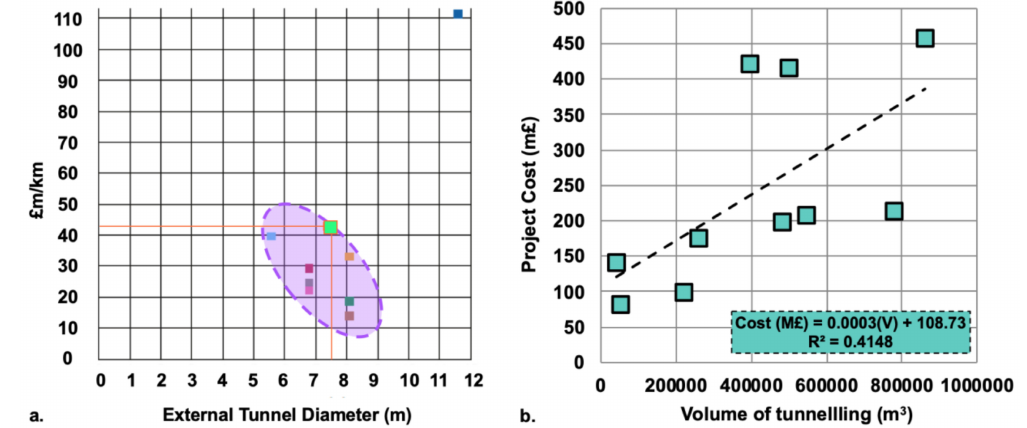
Figure 6. ( a ) Cost per diameter for English transport tunnels according to Infrastructure Project Authority (2018), showing the case of the Channel tunnel in light green. ( b ) Total project cost plotted against the volume of tunnelling in UK.